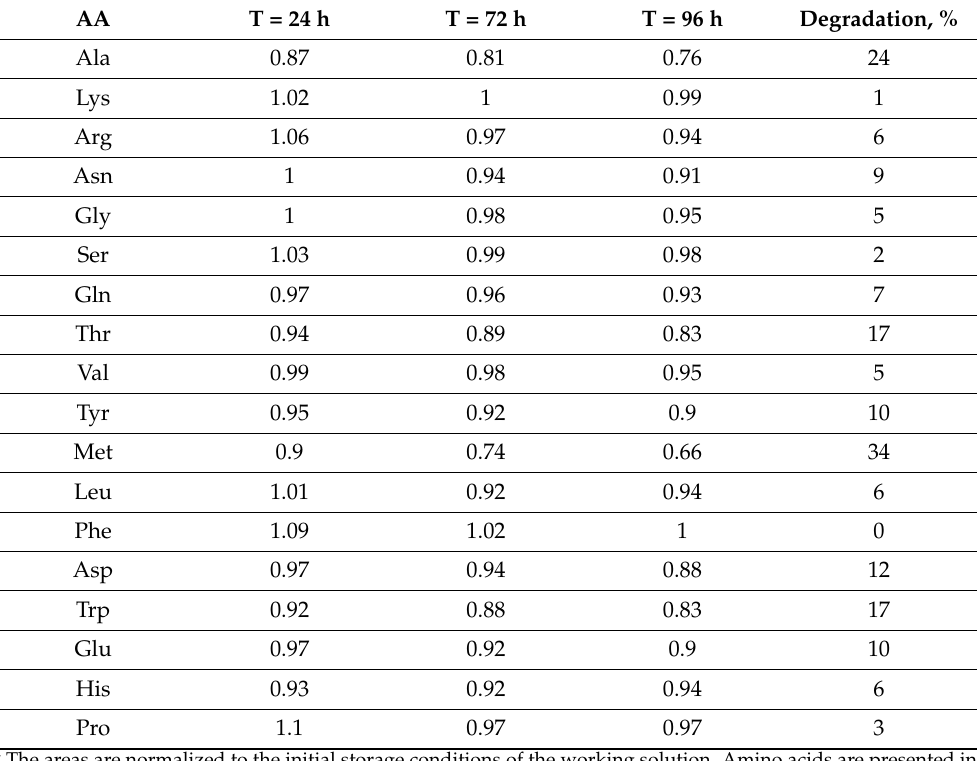
Table 5. Degradation of derivatized amino acids in solution when stored at 6 ◦ C for 24, 72, and 96 h. Data obtained using time-of-flight quadrupole MS *.